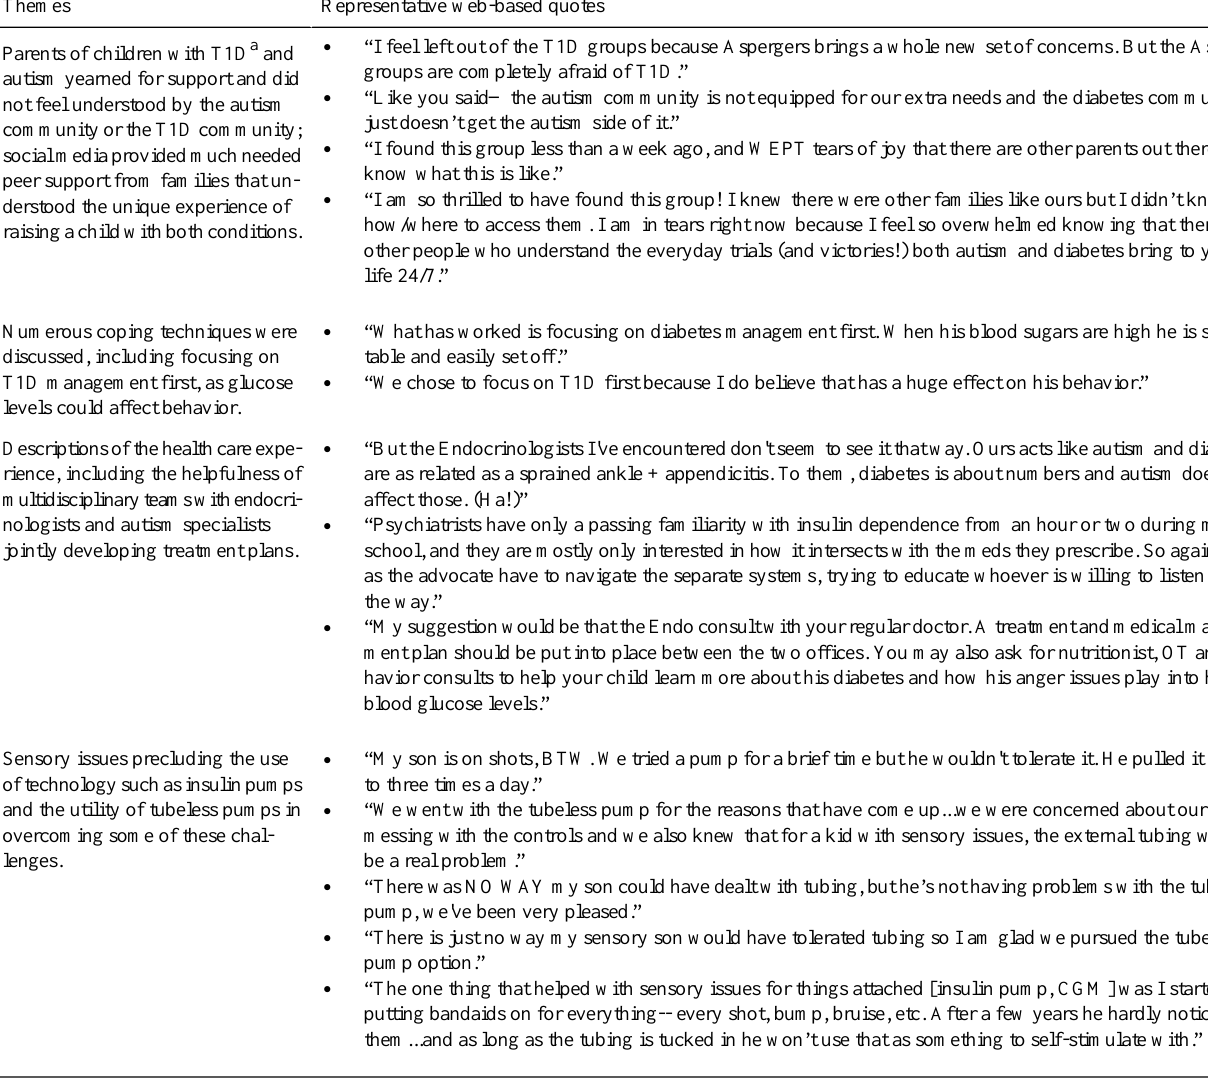
Table 1. Phase 1 themes and representative quotes from analysis of online forums and blogs. Representative web-based